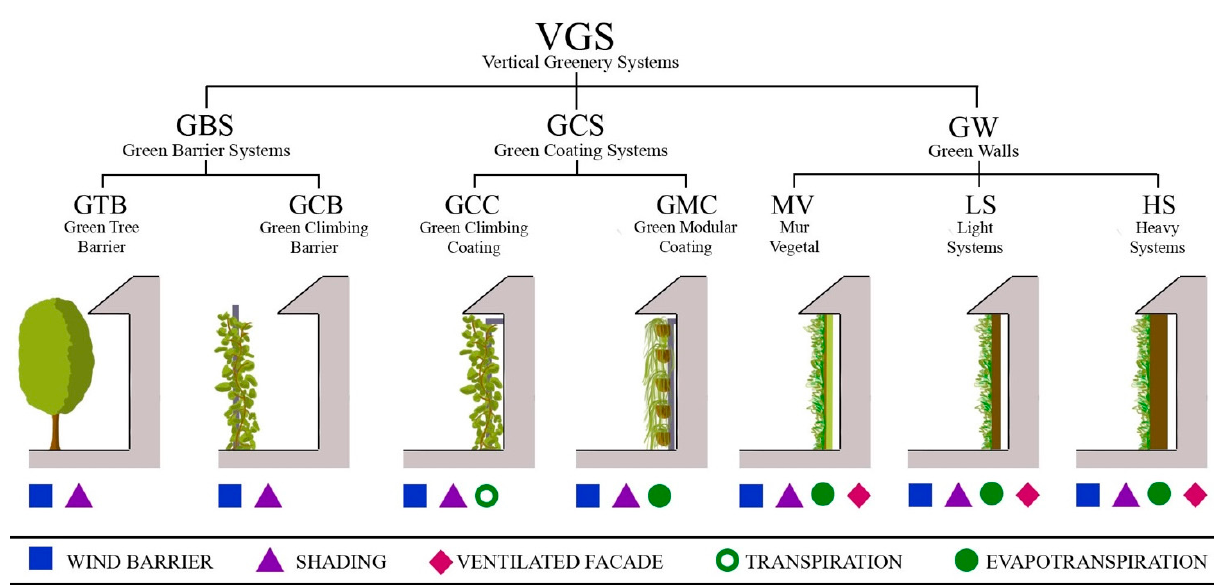
Figure 1. Proposed classification of VGS. Effects on buildings are specified for each category.